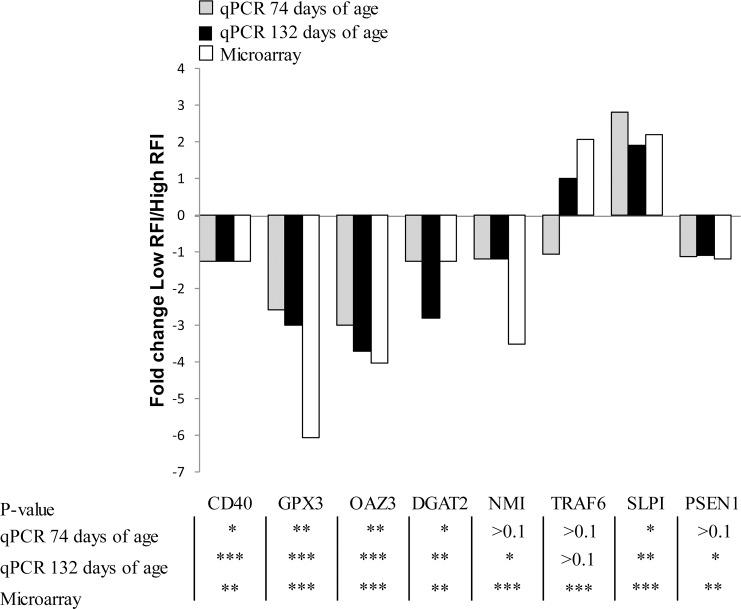
Comparison of microarray and qPCR data for eight genes in pigs divergently selected for low or high residual feed intake (RFI).Transcriptomic differences between the two lines were validated by qPCR at 132 and 74 days of age (onset of the growing period). For values related to microarray, the highest P-value is reported when several probes are differentially expressed for a unique gene (*P < 0.05; **P < 0.01; ***P<0.001). Fold change value is expressed as the expression ratio of low RFI to high RFI samples; ratio was inversed and preceded by a minus sign for value less than 1 (i.e., a ratio of 0.5 is expressed as -2). CD40, tumor necrosis factor receptor superfamily member 5; GPX3, glutathione peroxidase 3; OAZ3, ornithine decarboxylase antizyme 3; DGAT2, diacylglycerol O-acyltransferase 2; NMI, N-myc interactor; TRAF6, TNF receptor-associated factor 6; SLPI, secretory leukocyte peptidase inhibitor; PSEN1, presenilin 1.